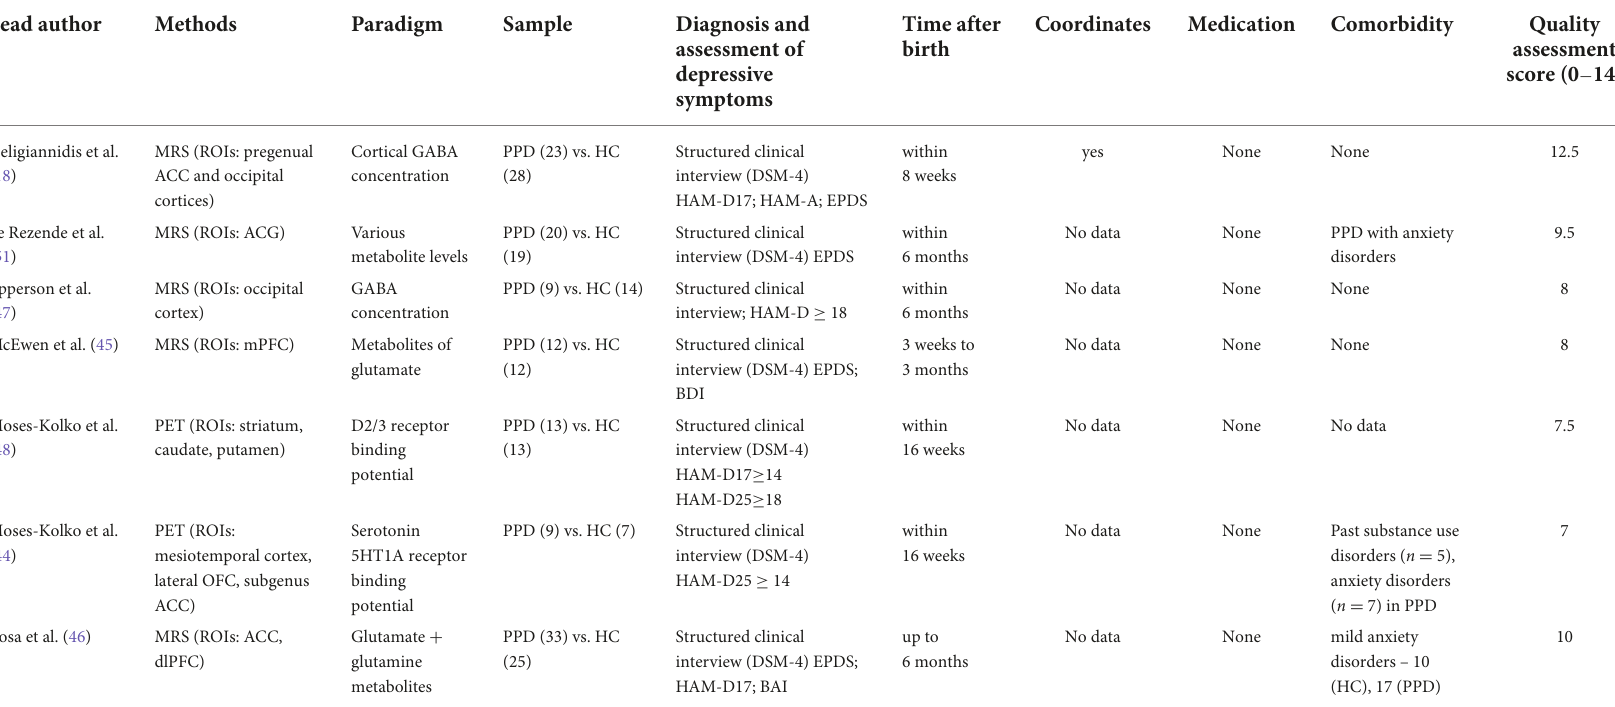
TABLE 3 Data extraction of metabolic